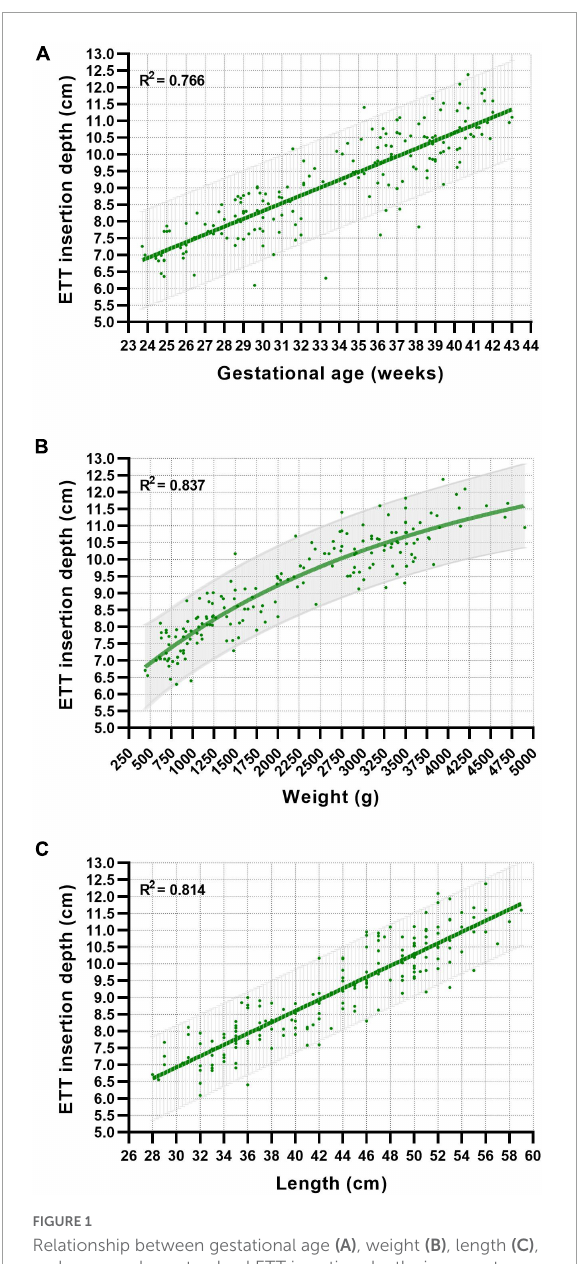
FIGURE1 Relationship between gestational age (A) , weight (B) , length (C) , and proposed nasotracheal ETT insertion depths in neonates. Best-fit curves and 95% prediction bands were generated using linear and non-linear regression models.